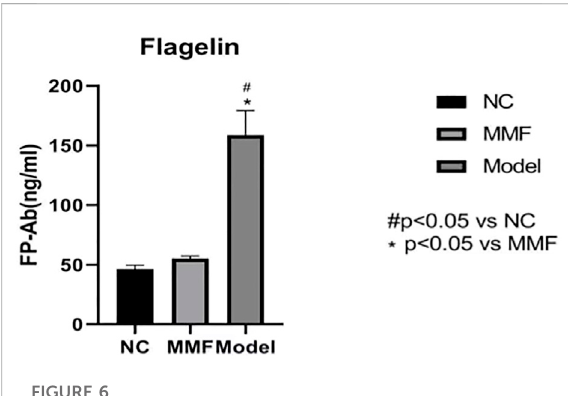
FIGURE 6 Flagellin content in colonic mucosa of rats in each